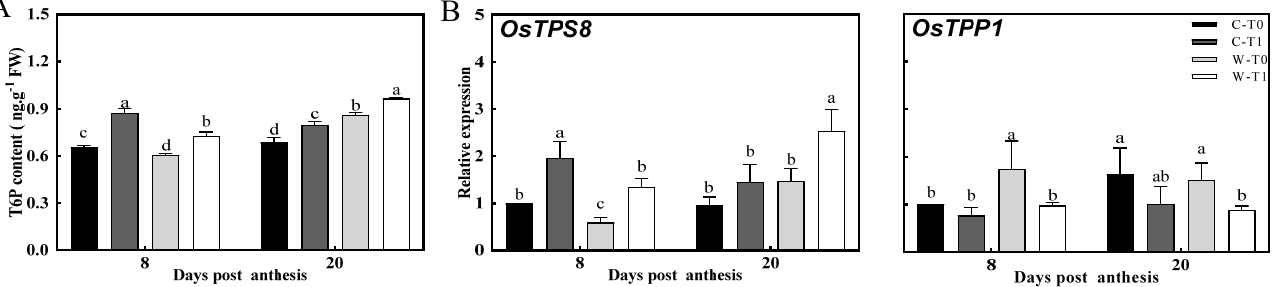
Figure 4. T6P content and gene expression with regards to the regulation of T6P level in the stems of 2020. ( A ) T6P content of stems during grain filling. ( B ) The expression of OsTPS8 and OsTPP1 in regulation of T6P level were validated by RT-PCR. C, CJ03; W, W1844; T0, control group; T0, control group without any treatment; T1, top 2/3 of the spikelets were removed; different letters from the same character under the same DPA indicate significant differences at the p = 0.05 level.